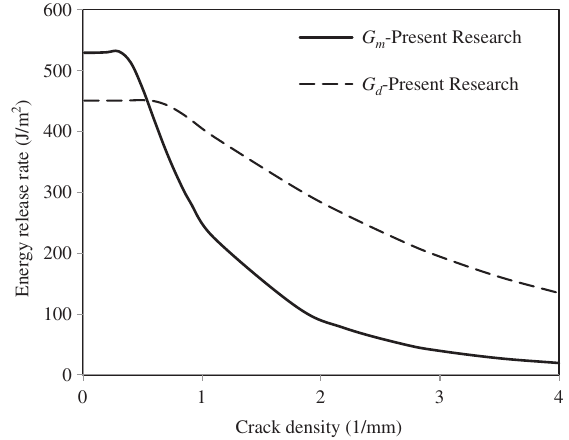
] s carbon/ 2 = 100 MPa, σ = 1 MPa and σ = 10 MPa. 1 12 2 Table 3: The critical energy release rates, critical crack densities and energy release rates due to induced delamination and